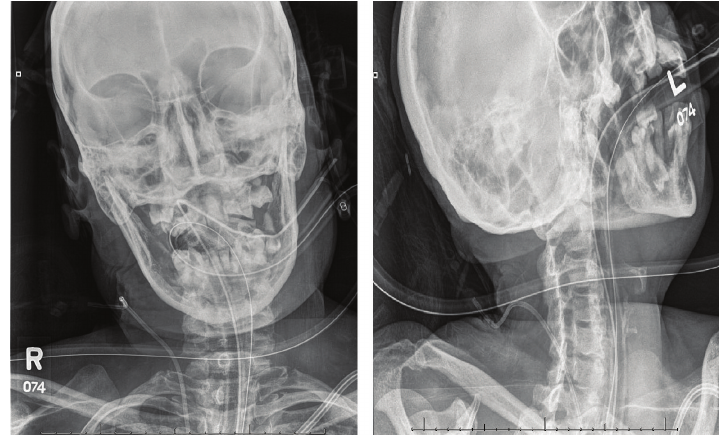
Figure 3: X-ray of the skull, showing lytic lesions in the mandible and bilateral maxillae.